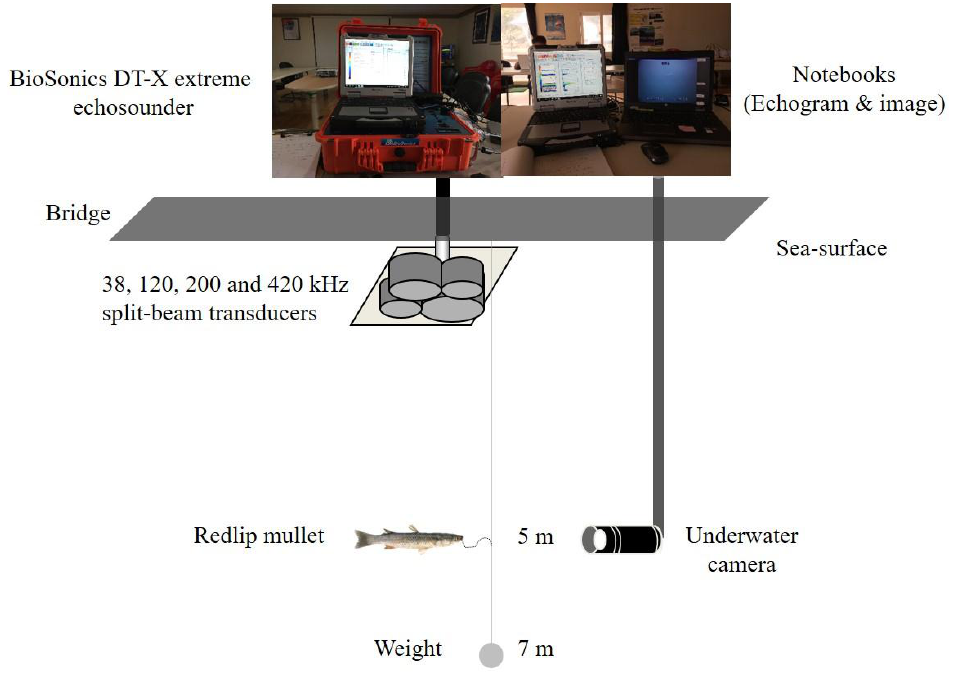
Figure 2. Experimental setup for the target strength ( TS ) measurements of Redlip mullet ( Chelon haematocheilus ) using a scientific echo-sounder (38, 120, 200, and 420 kHz).